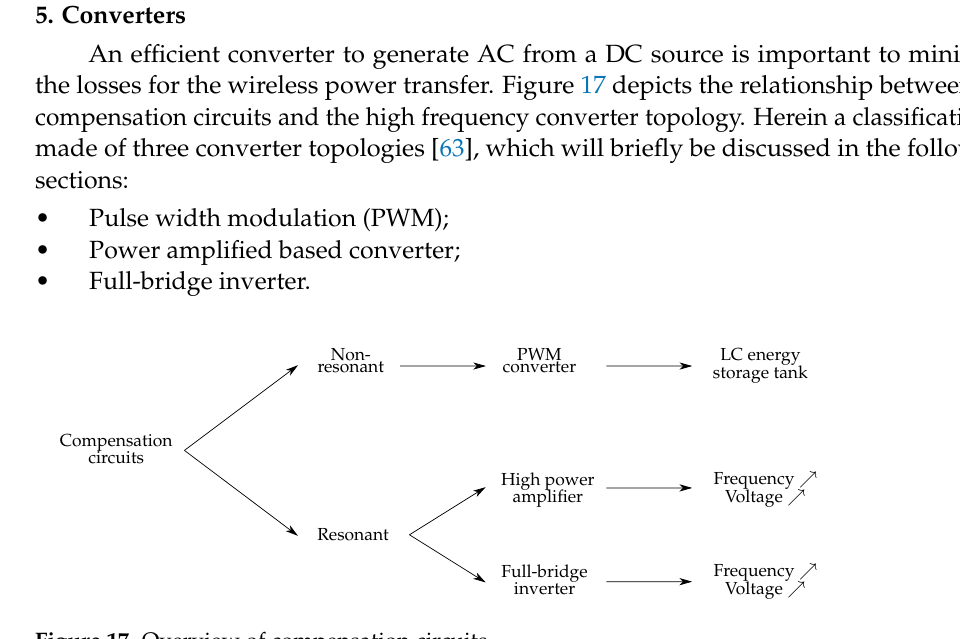
Figure 17. Overview of compensation